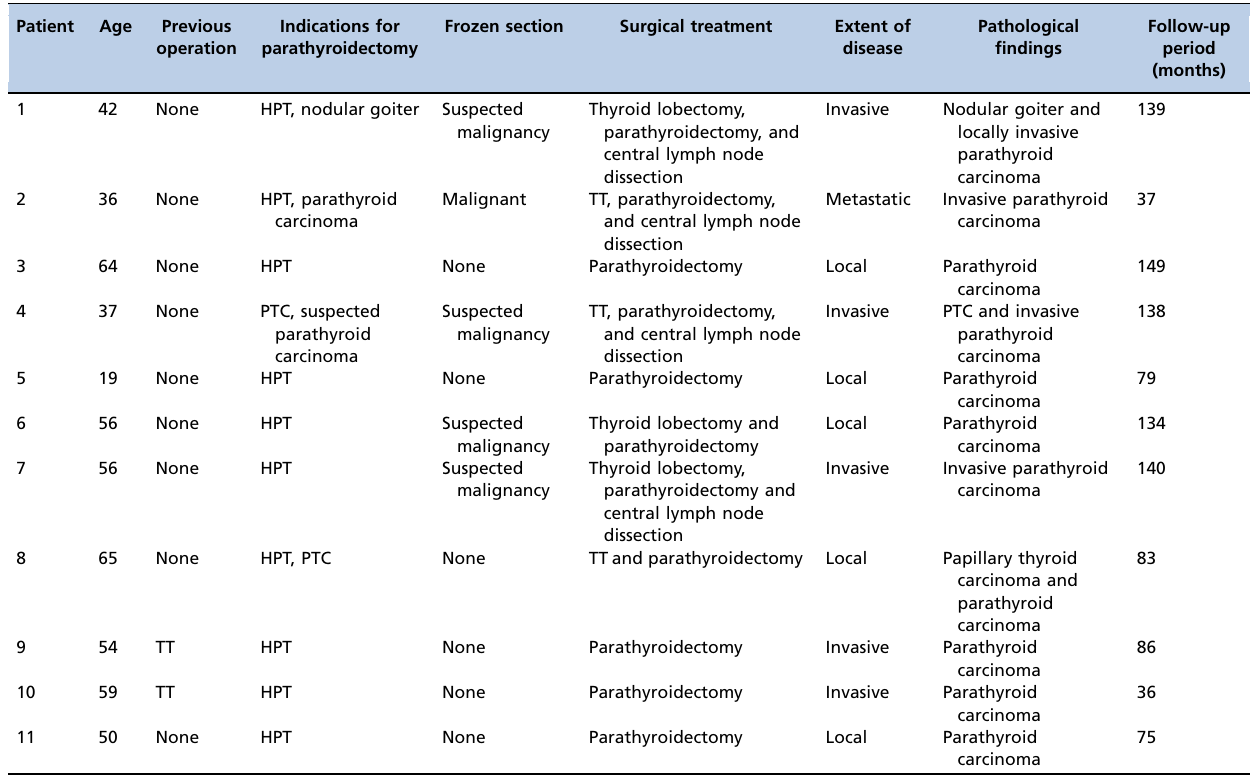
Table 3 - Patient characteristics.